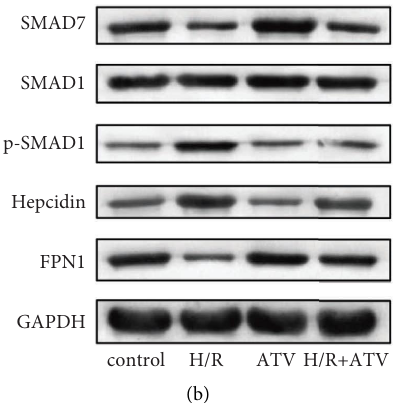
Figure 3: ATV activated the SMAD7 expression. (a). Te relative expression of SMAD7 and hepcidin was detected by qPCR. (b). WB was used to analyze the proteins expression. ∗ P < 0 . 05 vs. the control group. # P < 0 . 05 vs. the H/R